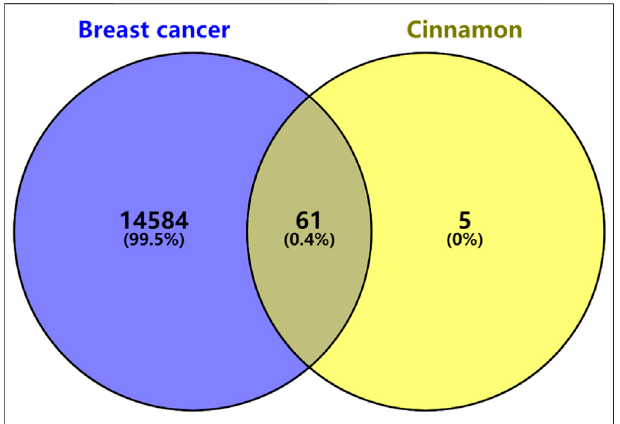
FIGURE2| Venndiagram ofthe targets inbreast cancerand